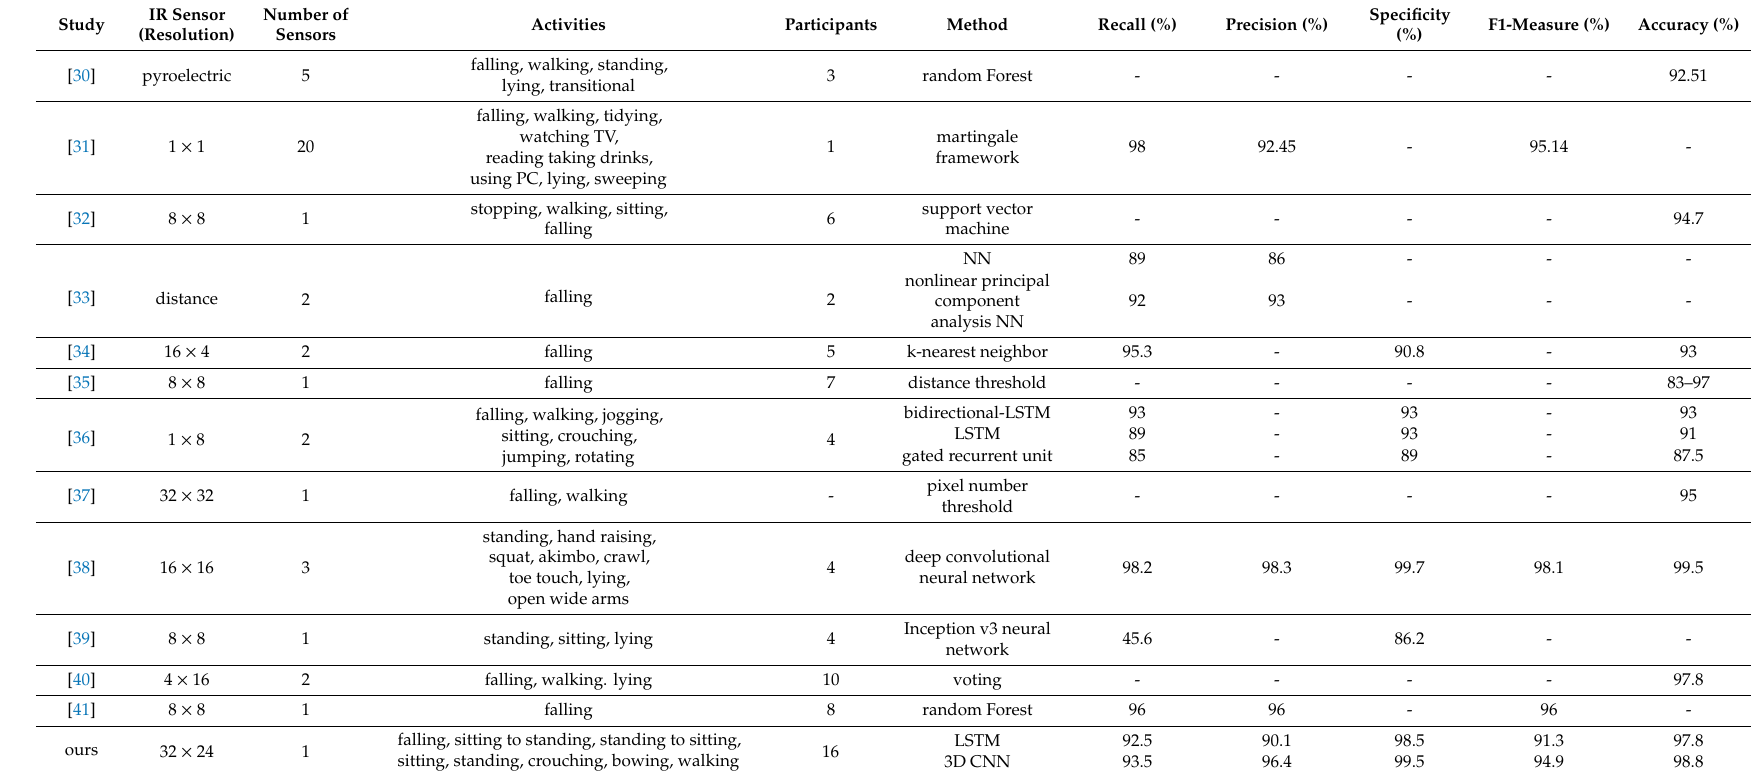
Table 8. Comparison with other studies using infrared